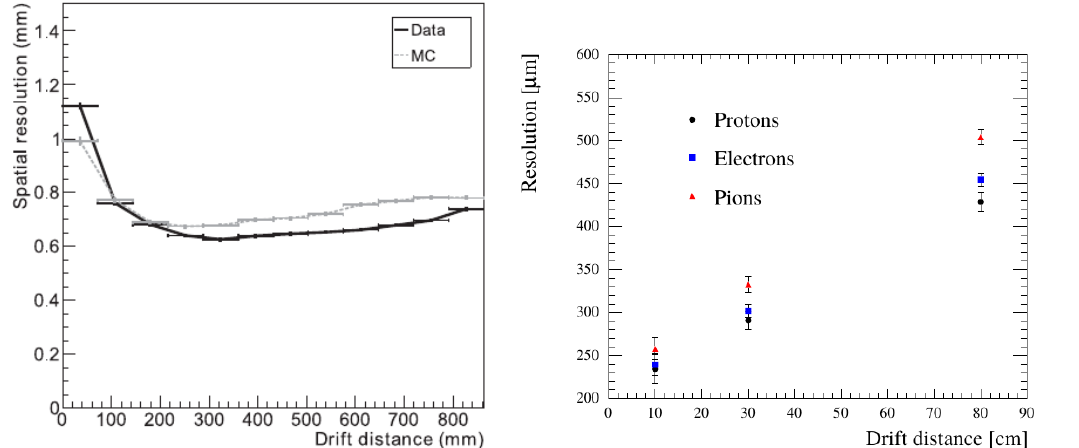
Figure 130. ( Left ): spatial resolution of the vertical TPCs in ND280 with beam events. ( Right ): spatial resolution obtained with a prototype of resistive Micromegas module on a test beam of 0.8 GeV positrons, pions and protons for different drift distances. Figures taken from Refs.